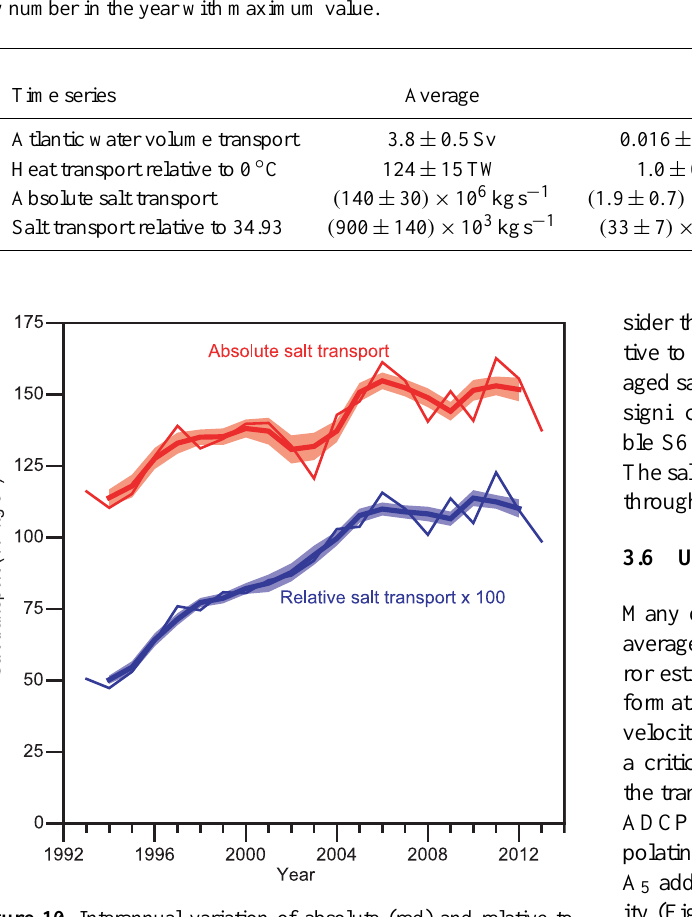
Figure 10. Interannual variation of absolute (red) and relative to 34.93 (blue) salt transport 1993–2013. Annually averaged trans- ports (thin lines) and 3-year averaged transports (thick lines) with the background representing ± one standard error over each 3-year period. The values for relative salt transport have been multiplied by 100 to fit the same scale as the absolute salt